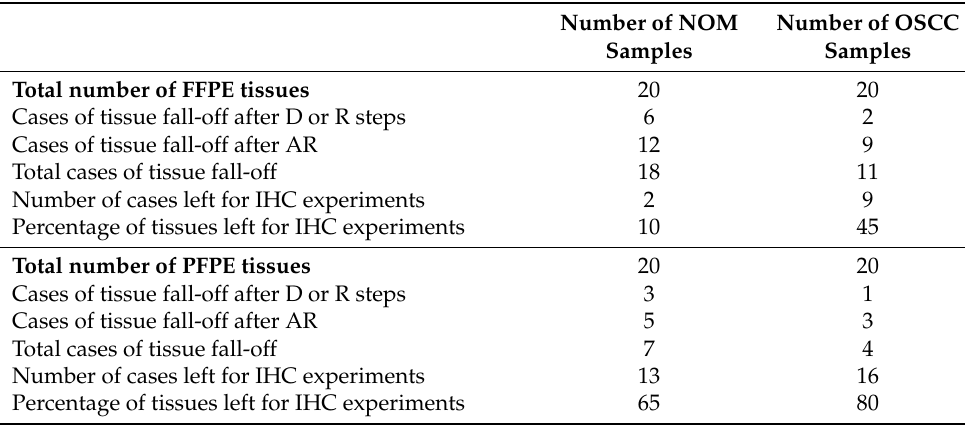
Table 4. Documentation of cases of tissue section fall-off from slides during sample processing steps for immune-histochemical staining experiments for matched PFPE and FFPE tissue